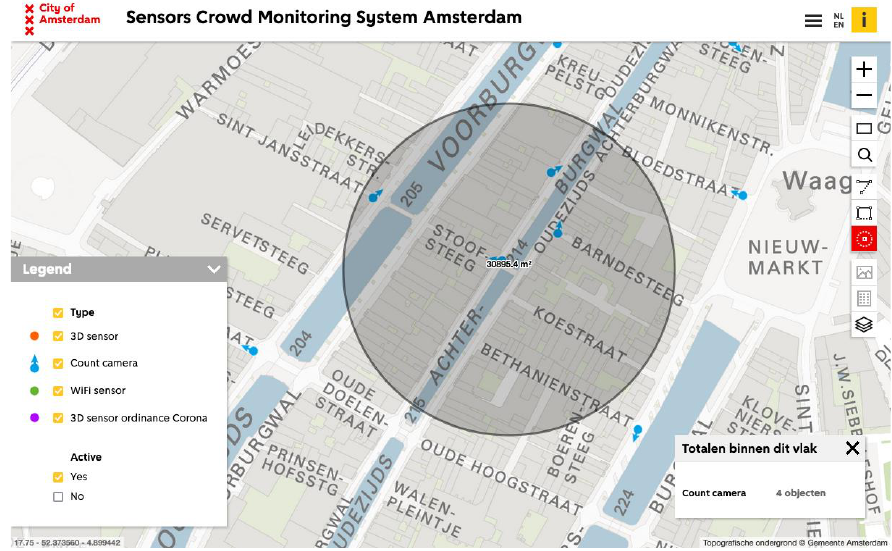
Figure 2. Active Crowd Monitoring Sensors within 100m of the Bridge.